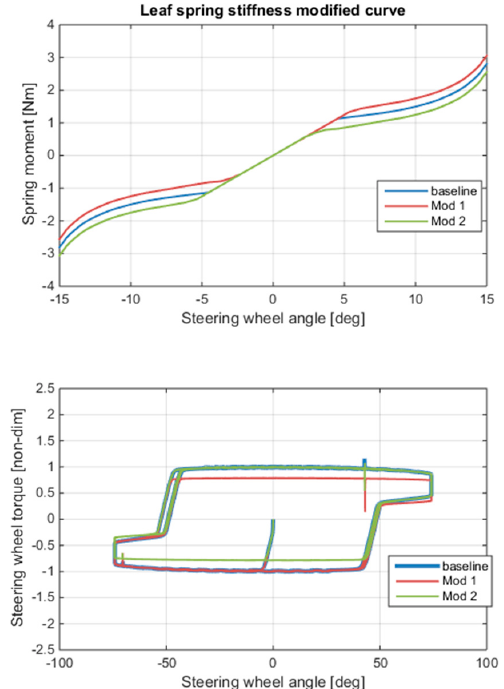
Figure 14. Different leaf spring stiffness and corresponding steering wheel torque-angle curve.